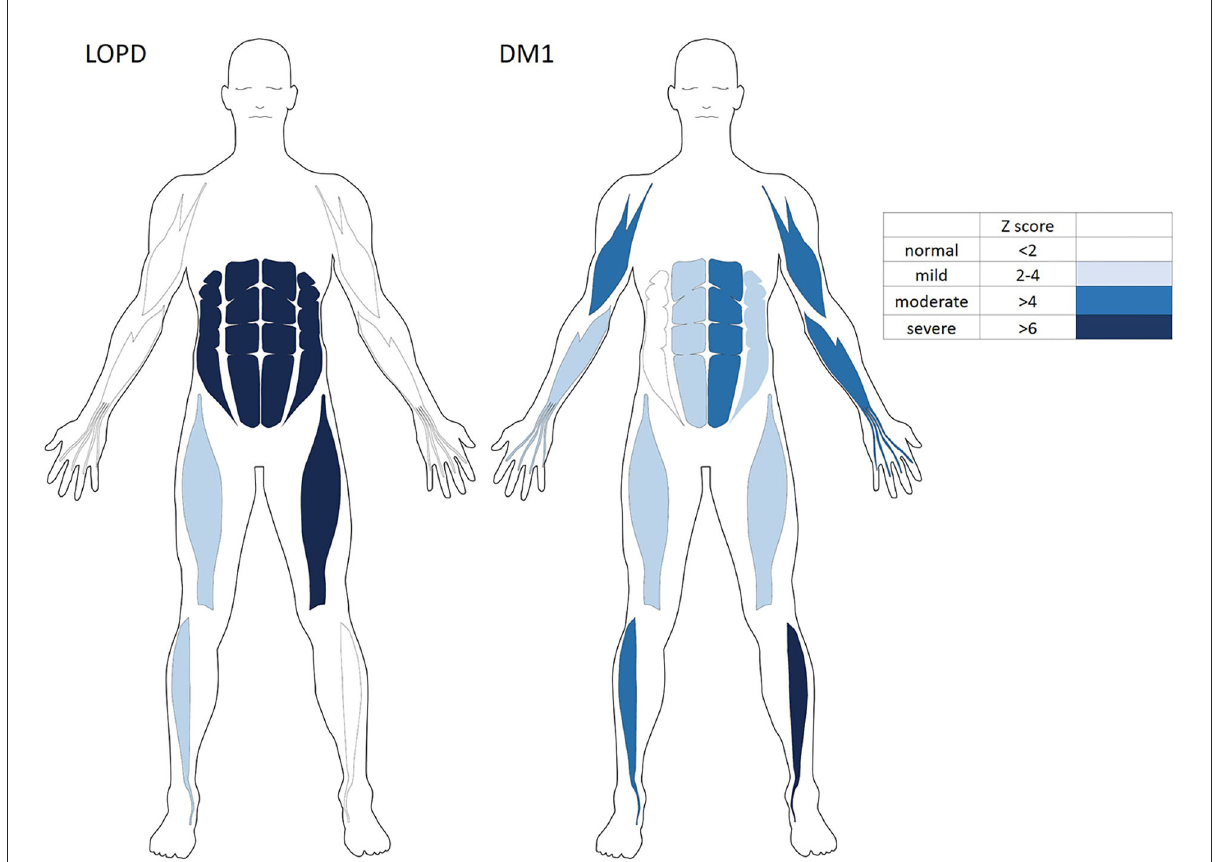
FIGURE3 The variable severity and distribution of qualitative echogenicity in skeletal muscles of the LOPD and Patients with DM1. DM1, Myotonic dystrophy type 1; LOPD, Late-onset Pompe